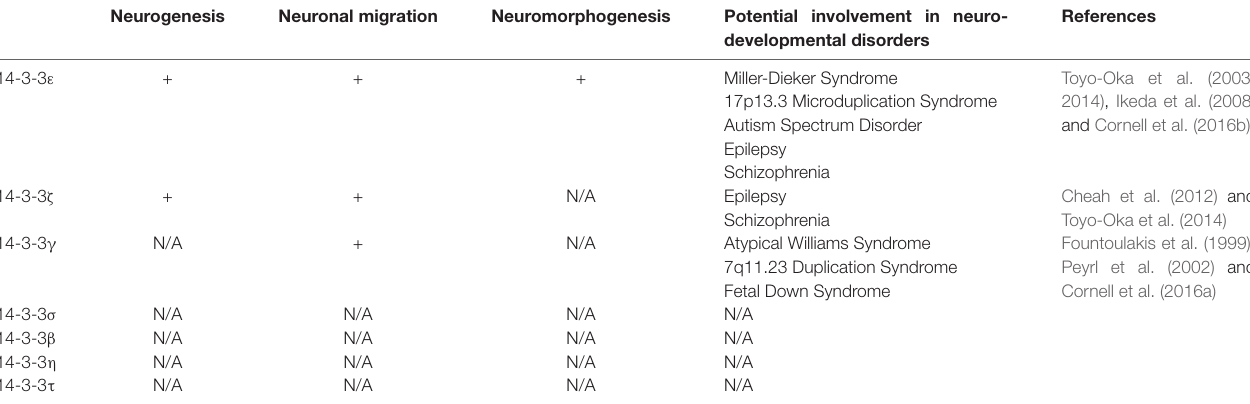
TABLE 1 | Summary of the involvement of 14-3-3 isoforms in three stages of cortical development and each isoform potential involvement in related neurodevelopmental